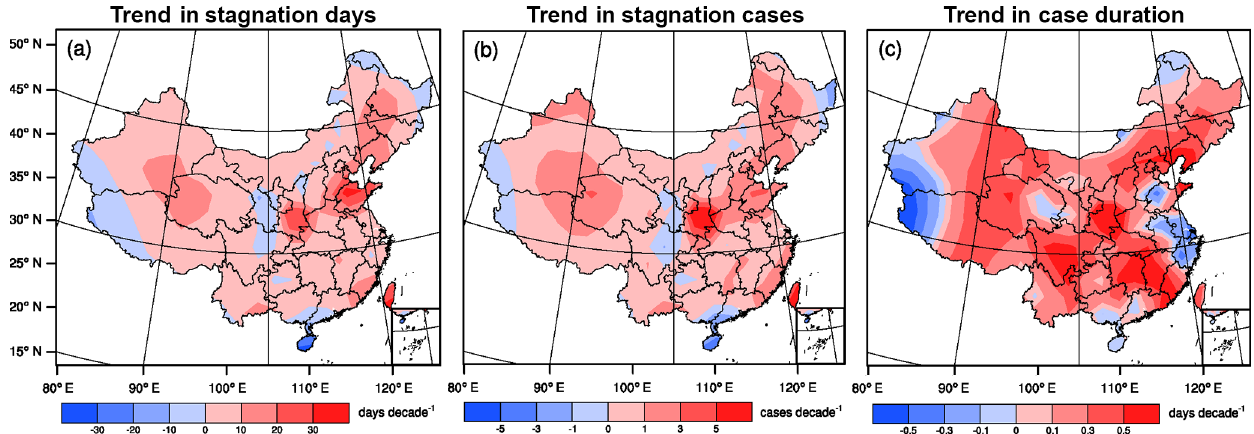
Figure 5. Trends in stagnation days (a) and cases (b) and the duration of stagnation cases (c) during 1985–2014.